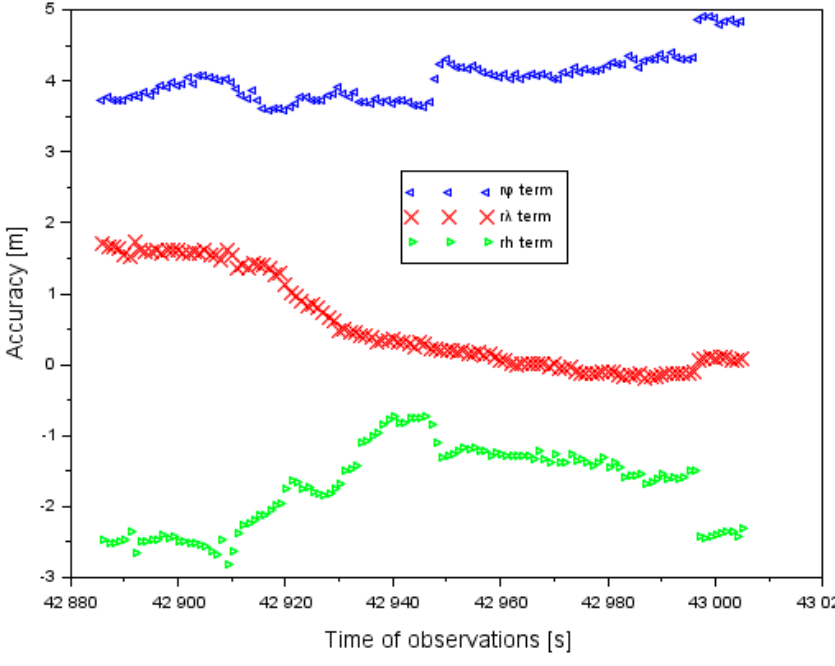
Figure 5. Vertical profile of the Cessna 172 during the landing process at Che ł m airport.